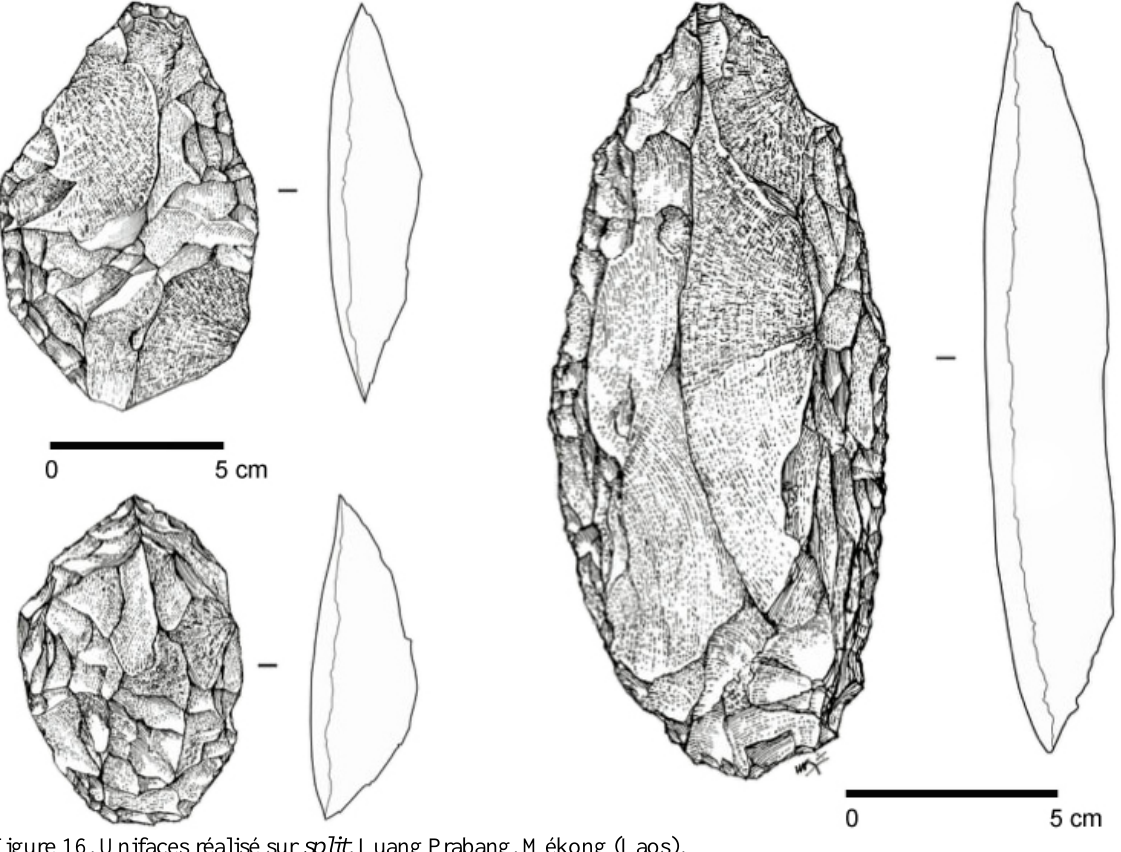
Figure 16. Unifaces réalisé sur split , Luang Prabang, Mékong (Laos). Figure 16. Uniface made on split from Luang Prabang, Mekong river,